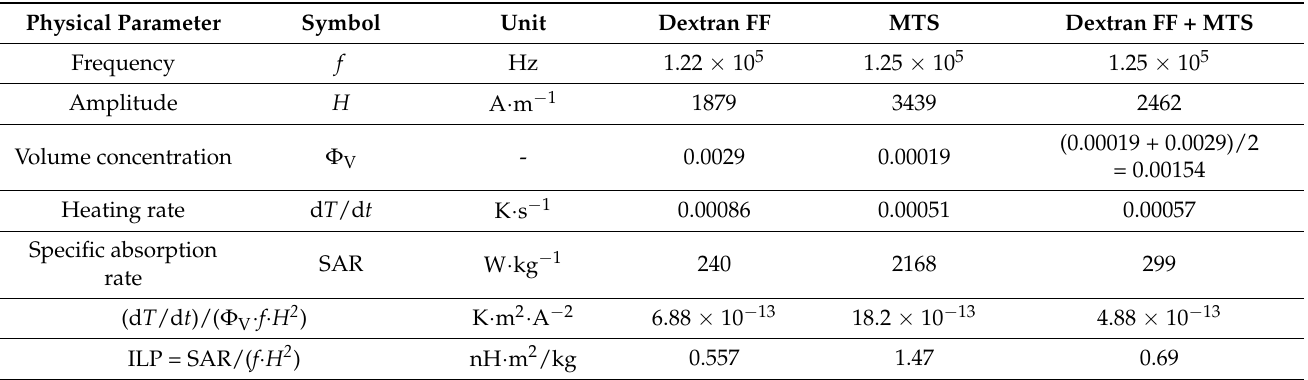
Table 4. Comparison of the heating effect in the tested samples of different physical parameters in an